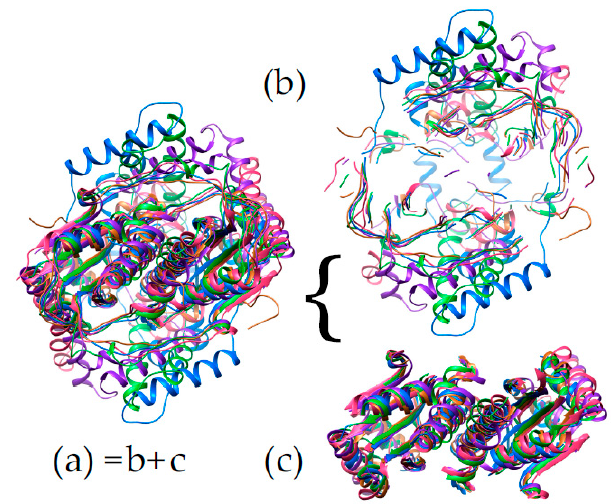
Figure 6. Superposition of NR-related superfamily members. ( a ) Common core structure is evident in an overlay of representatives of each of the NfsB (green), NfsA (blue), PnbA (purple) Frm2 (pink) and HUB (rust) subgroups. Panel ( c ) extracts the core secondary structure shared by the different subgroups (same overlay), while ( b ) shows all backbone ribbon present in ( a ) but excluded from ( c ). Structures used are 1F5V (NfsA), 5J8D (NfsB), 2WZW (PnbA), 2IFA (Frm2) and 3E39 (HUB). All molecular graphics were produced using Chimera [79].